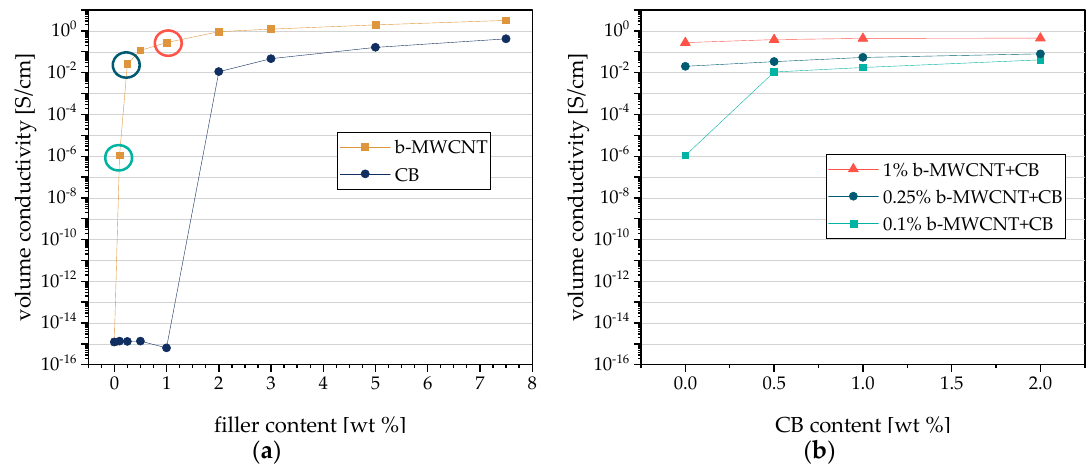
Figure 2. Volume in-plane conductivity of poly (vinylidene fluoride) (PVDF) composites with different fillers ( a ) branched multi-walled carbon nanotubes (b-MWCNT), carbon black (CB), ( b ) mixed filler systems of b-MWCNT and CB in PVDF1. The circles in ( a ) mark the concentrations of b-MWCNTs used in ( b ).